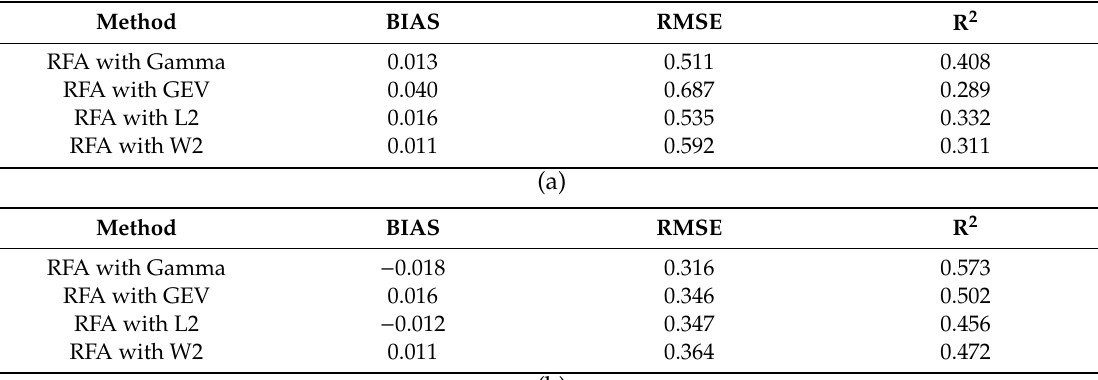
Table 7. Comparison of the validation results based on the di ff erent statistical distributions for the regional frequency analysis for the ( a ) two-year quantile and ( b ) five-year quantile.